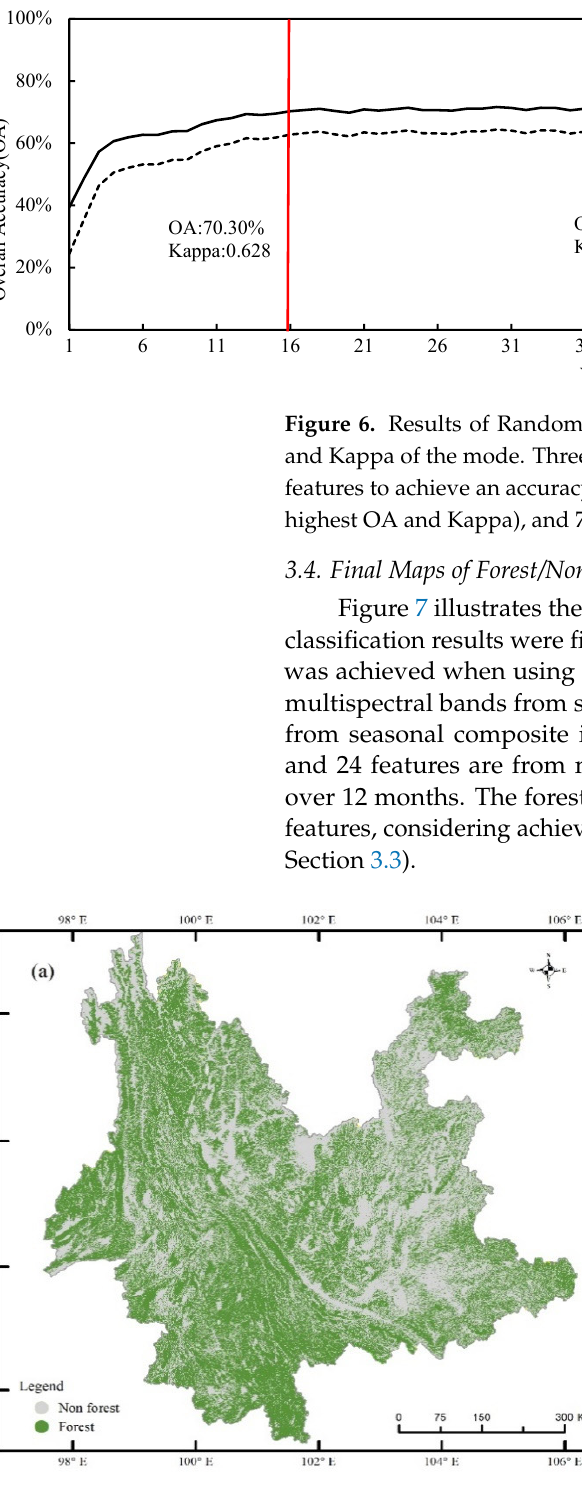
Figure 7. The classification results of this study. ( a ) the forest/non-forest map of Yunnan; ( b ) the forest type map of Yunnan.